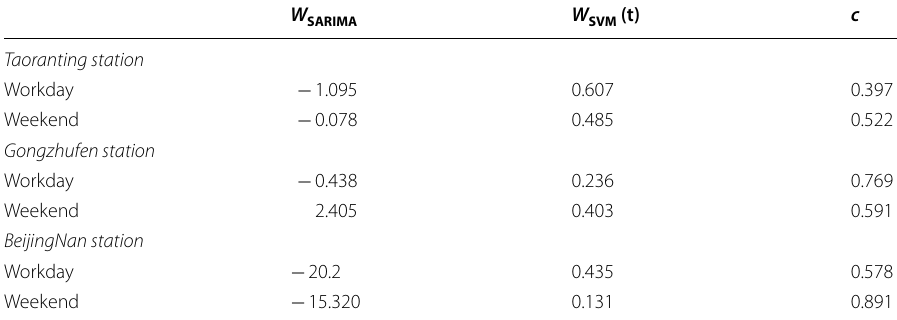
Table 3 Multiple regression coefficient